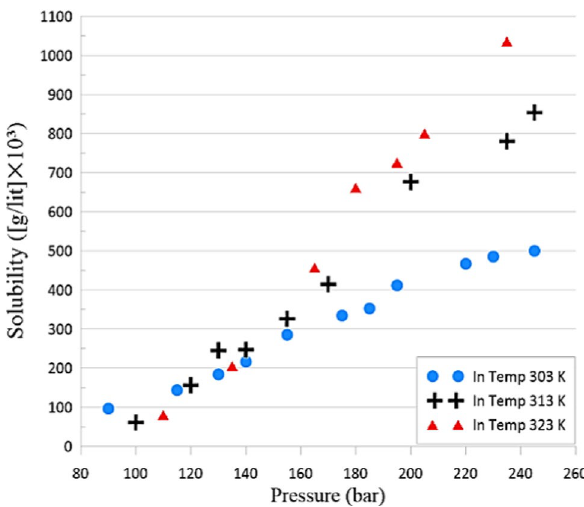
Figure 3. Solubility of Vitamin A vs pressure (at various